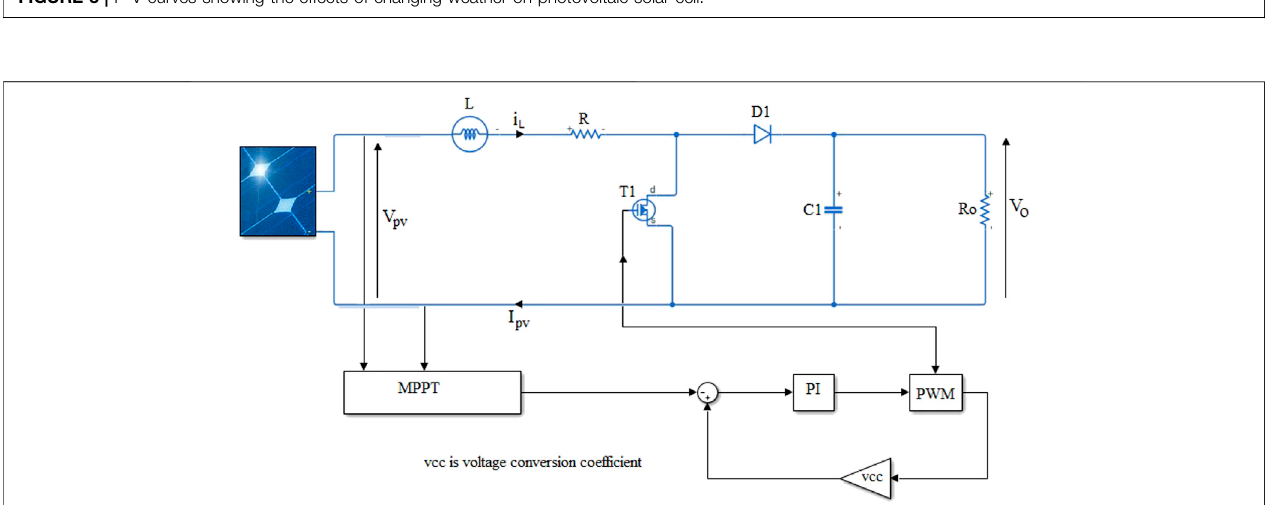
FIGURE 3 | P-V curves showing the effects of changing weather on photovoltaic solar cell.